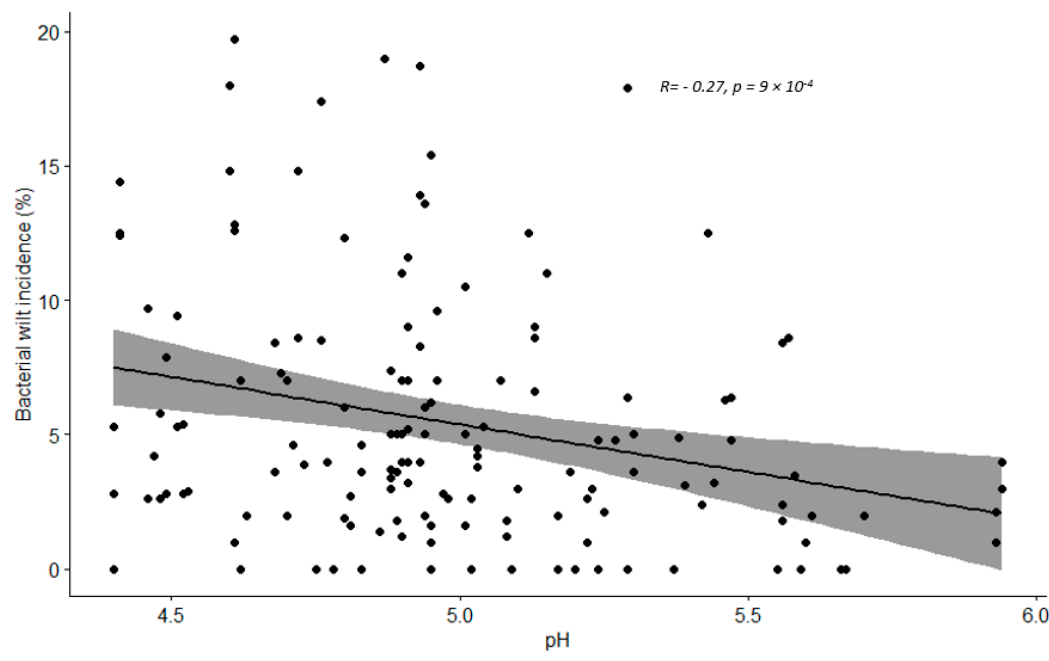
Figure 3. Correlation between soil acidity and bacterial wilt incidence in different potato fields. Each point indicates an observation of soil pH and bacterial wilt incidence from a different potato